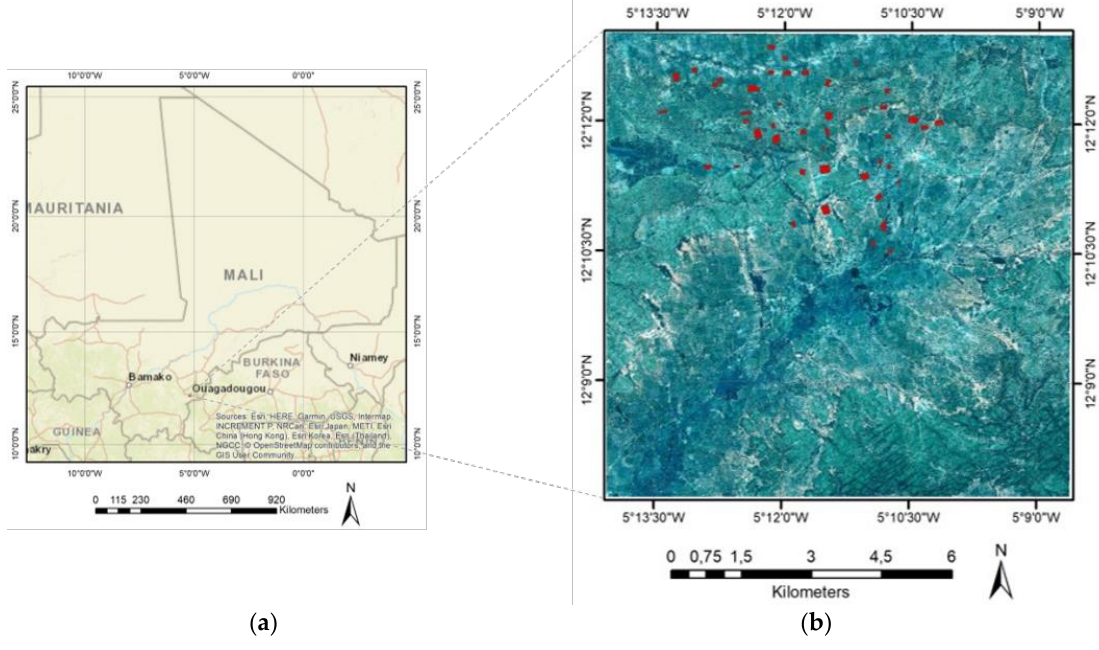
Figure 1. Study area. ( a ) Location of the study area in Mali; ( b ) The study’s field plots overlapping a Worldview-2 image of the study area on 18 October 2014 using natural color composite.